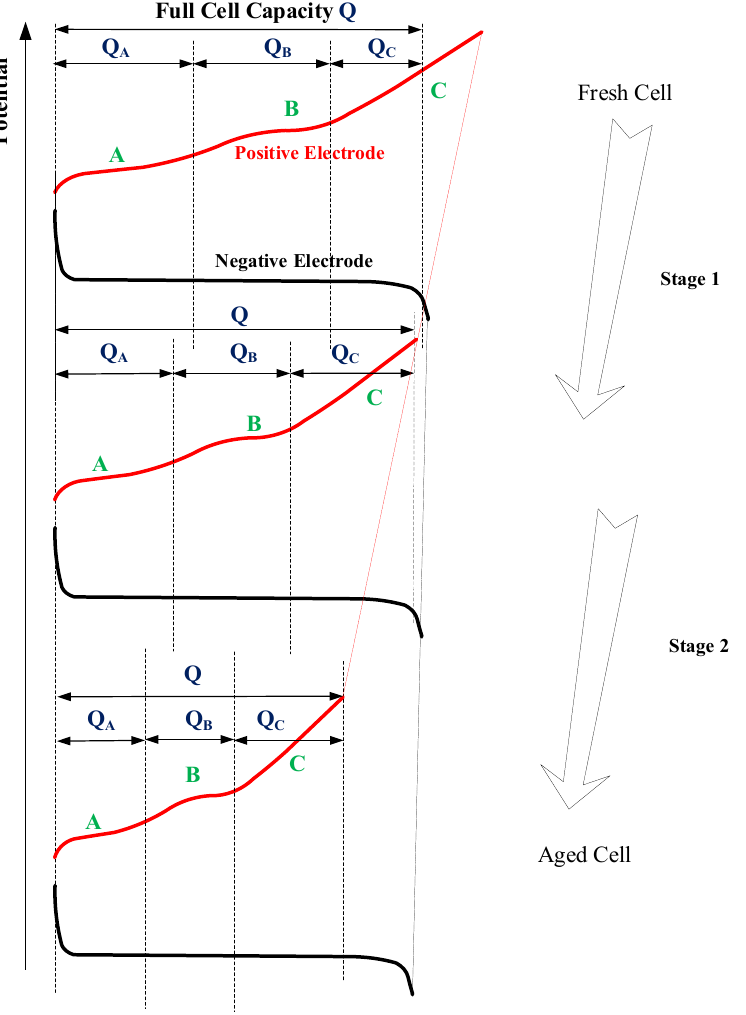
Figure 8. Schematic of the two stage capacity fade